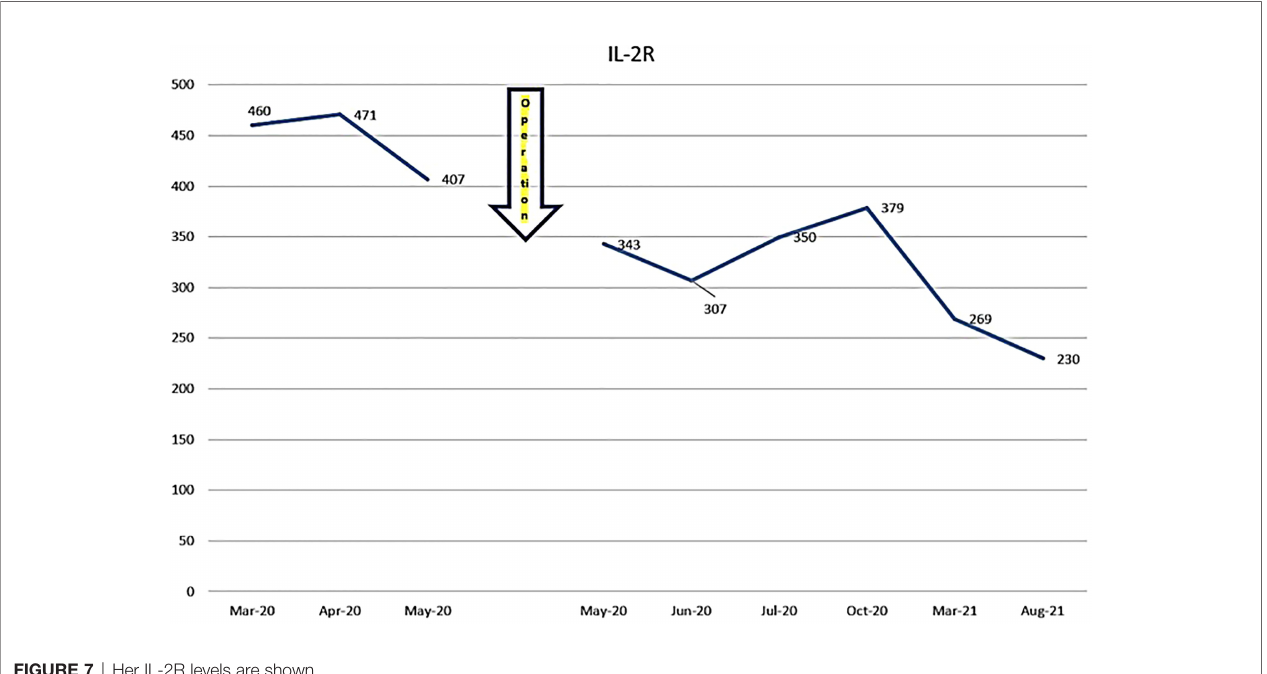
FIGURE 7 | Her IL-2R levels are shown.